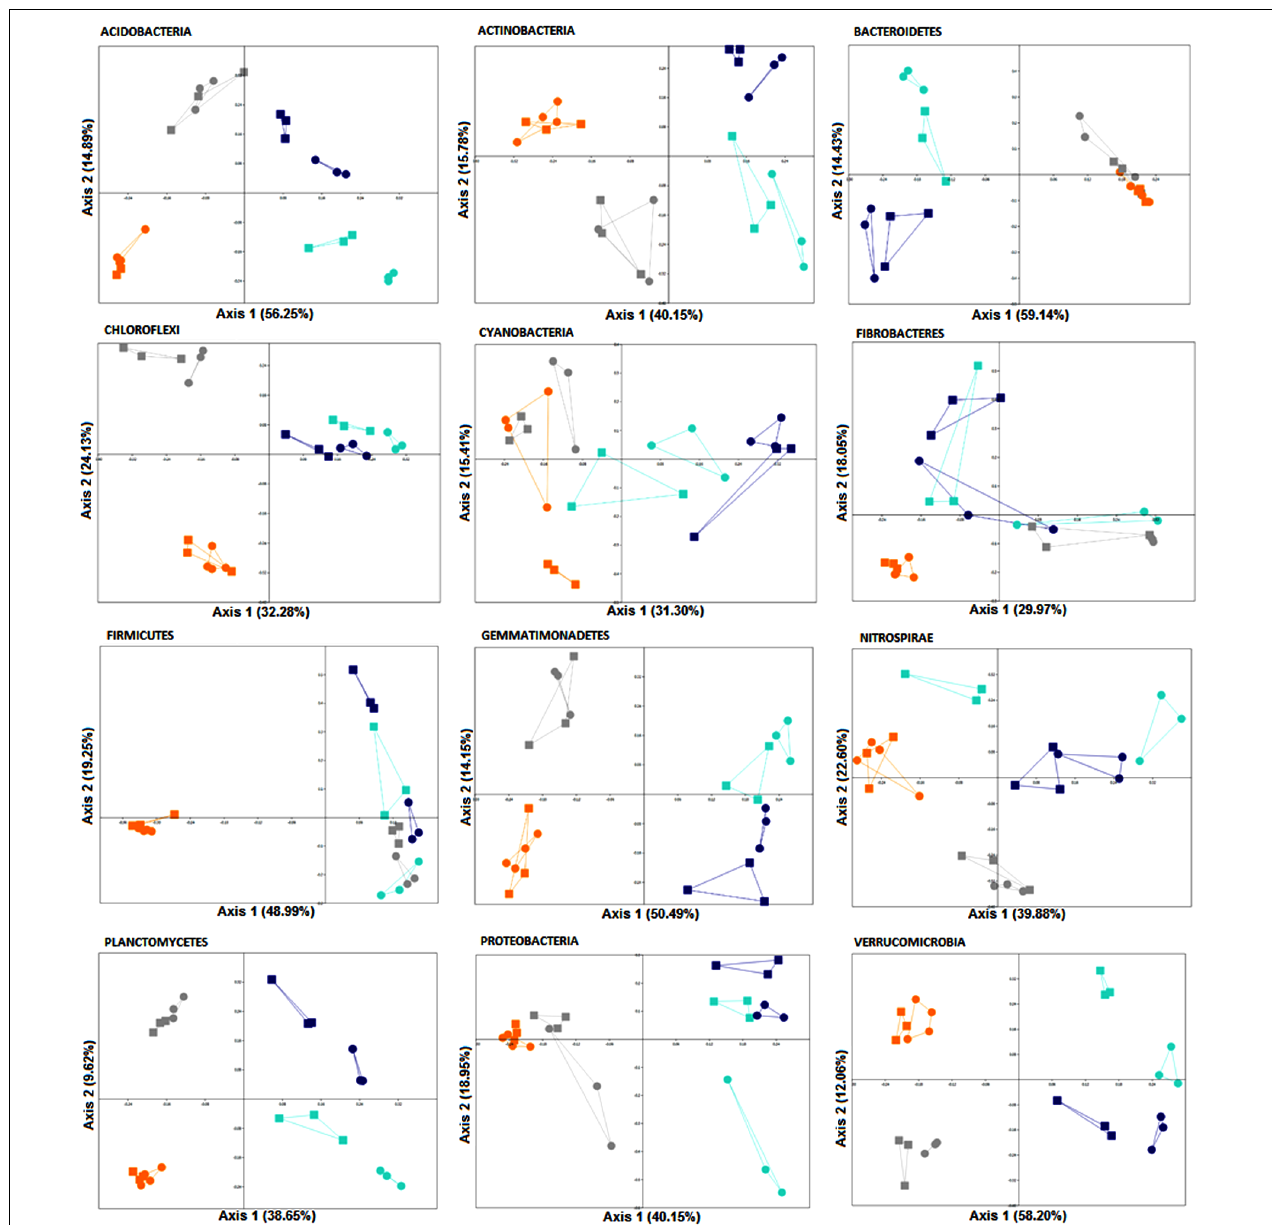
FIGURE 5 | PCoA plots generated for each phylum based on Bray-Curtis distance of rhizosphere bacterial communities associated with wheat grown in soils under different fertilization regime (orange = organic N, gray = zero N, turquoise = medium inorganic N, and dark blue = high inorganic N), collected at two stages (4 and 10 weeks). The percentage shown in each axis corresponds to the proportion of variation explained. Squares represent samples collected after 4 weeks and circles represent samples collected after 10